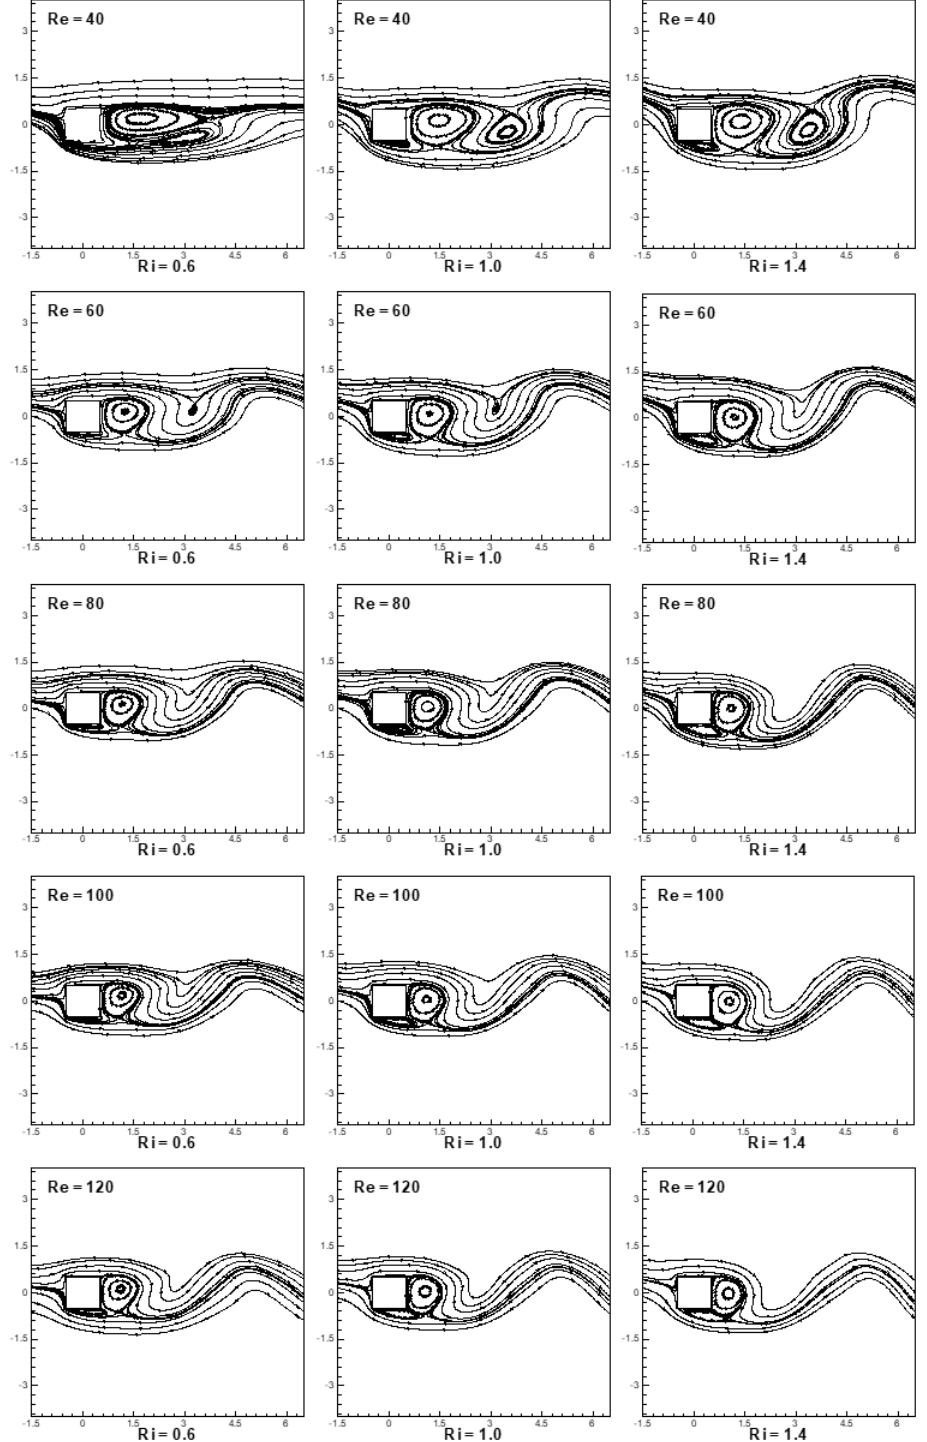
Figure 7. Instantaneous streamline patterns in the vicinity of the square cylinder for the conditions (α = 90 °, 40 ≤ Re ≤ 120 and 0.6 ≤ Ri ≤ 1.4) in the same phase of the shedding cycle.